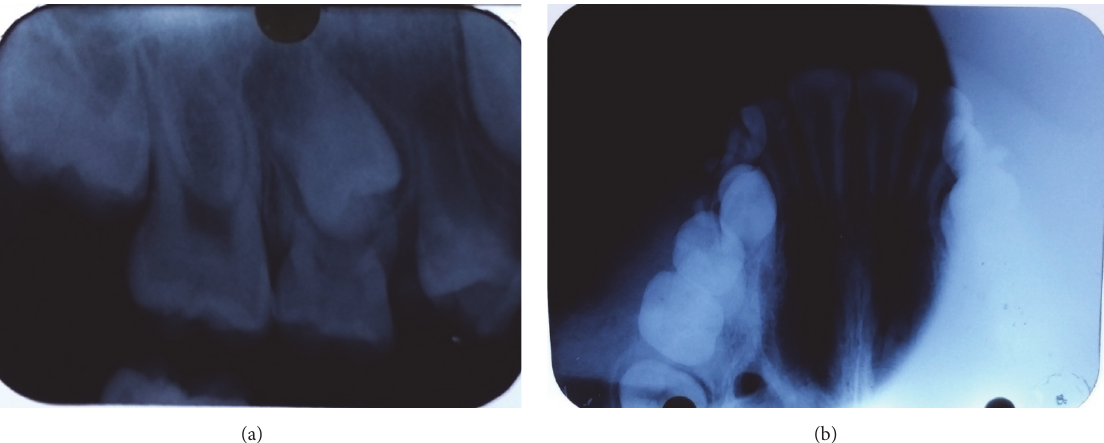
Figure 2: (a) Showing granular trabecular pattern in the IOPA of maxillary right back tooth region. (b) Showing maxillary true occlusal radiograph of same region with granular trabecular pattern, increased buccal cortical expansion, and mild palatal cortical